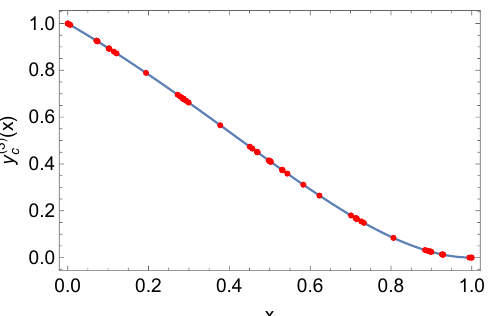
( 3 ) ( x ) . A proper subset of the set of points S is c